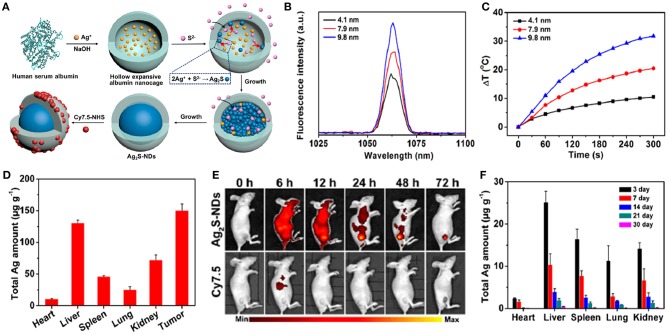
(A) Schematic illustration of construction of theranostic Ag2S nanodots in HSA Nanocages. (B) Fluorescence spectra of Ag2S-NDs. (C) Temperature elevations of Ag2S-NDs under 5 min irradiation (785 nm, 1.5 W cm−2). (D) Biodistribution of Ag2S-NDs at 24 h post-injection. (E) NIR fluorescence imaging of 4T1-tumor-bearing mice treated with Cy7.5-labeled Ag2S-NDs at 72 h post-injection. (F) Long-term distributions of Ag2S-NDs in various major tissues during 30 days post-injection. Dose: 50.0 μmol kg−1 Ag.